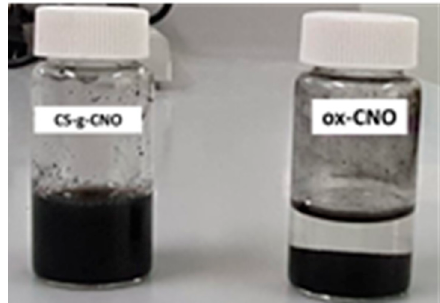
Figure 1. Image of ox-CNO and CS-g-CNO in 2% acetic acid dilution after 30 days.